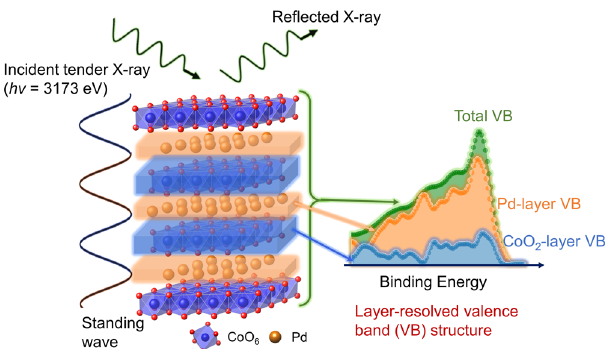
Fig. 1 Schematic fi gure describing the measurement of the layer-resolved electronic structure of PdCoO 2 with standing-wave X-ray photoemission spectroscopy (SW-XPS). A standing wave is excited in the material using tender/hard X-rays with a photon energy of 3173eV. While traditional angle-integrated photoemission spectroscopy only measures the total valence band (VB) structure (shown in green, denoted by “ Total VB ” ), SW- XPS allows the separation of the total VB structure into contributions from the Pd layer (shown in orange, denoted by “ Pd-layer VB ” ) and from the CoO 2 layer (shown in blue, denoted by “ CoO 2 -layer VB ”